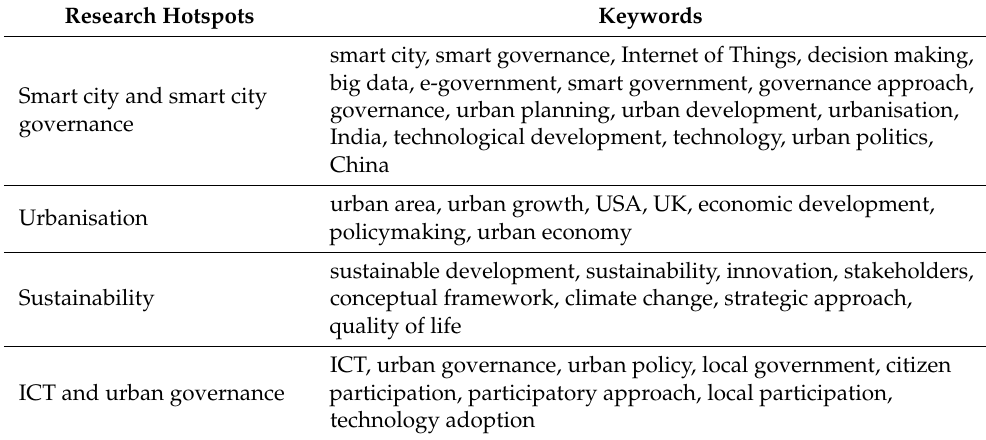
Table A2. Research subfields based on authors’ keyword co-occurrence network in SPG smart gov- ernment research.